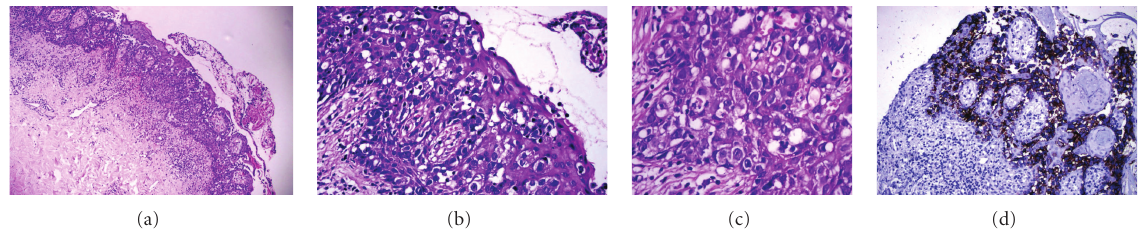
Figure 4: Atypical cellular proliferation with clear cytoplasm and large hyperchromatic nuclei arrangement in the basal lamina of the epidermis and epidermotropism towards the upper rows of the epidermis (H&E (a) × 100, (b) × 200, and (c) × 400). (d) Positive staining for epithelial membrane antigen (EMA) in the immunohistochemical staining ( ×